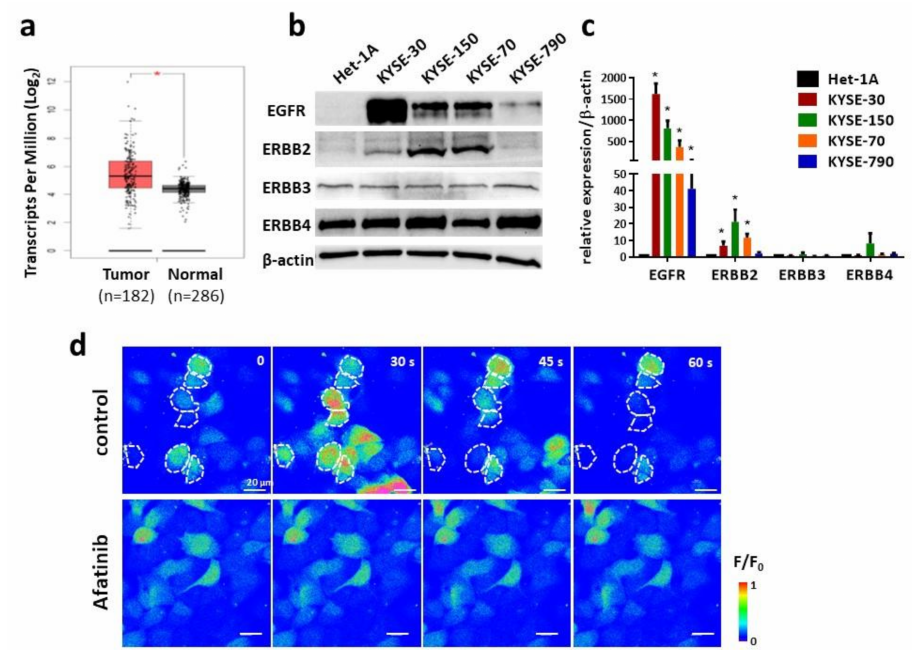
Figure 1. Upregulated expression of EGFR and ERBB2 and inhibited Ca 2+ oscillations by afatinib in ESCC cells. ( a ) RNA-Seq data (TCGA) revealed significant higher expression of EGFR in tumor vs. normal tissues removed from patients. Average expression level (TPM) for tumor and non-tumor is 38.4 and 20.4, respectively. Tumor ( n = 182), including ESCC ( n = 94), EAC ( n = 87) and cystic, mucinous and serous neoplasms ( n = 1). Normal ( n = 286), including TCGA adjacent normal ( n = 13) and GTEx normal esophageal tissue ( n = 273); * p -value < 0.0001. ( b ) Western Blot results of EGFR family members (EGFR, ERBB2, ERBB3 and ERBB4) in ESCC and Het-1A cells. β -actin was used as loading control. ( c ) Quantification of Western blot result of EGFR family members in ESCC and Het-1A cells; * p -value < 0.05. ( d ) Time-lapse live-cell fluorescent imaging of intracellular Ca 2+ in KYSE-150 cells. Cells were treated with either vehicle control or 5 µ M afatinib for 4 h. The intracellular Ca 2+ concentrations were presented by a heap map with fluorescent intensity changes (F/F0). Some representative cells with obvious Ca 2+ oscillations were indicated by dashed white circle. Scale bar, 20 µ